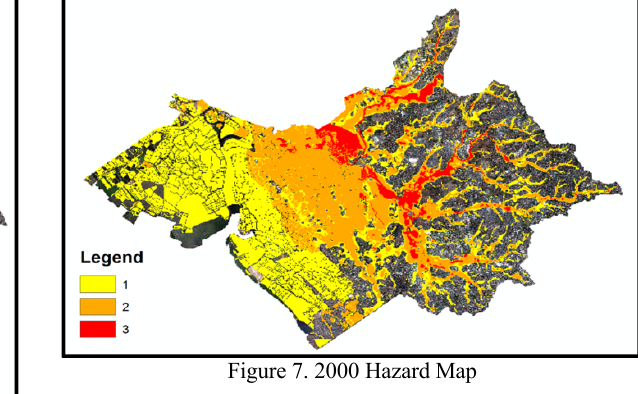
Figure 7. 2000 Hazard Map